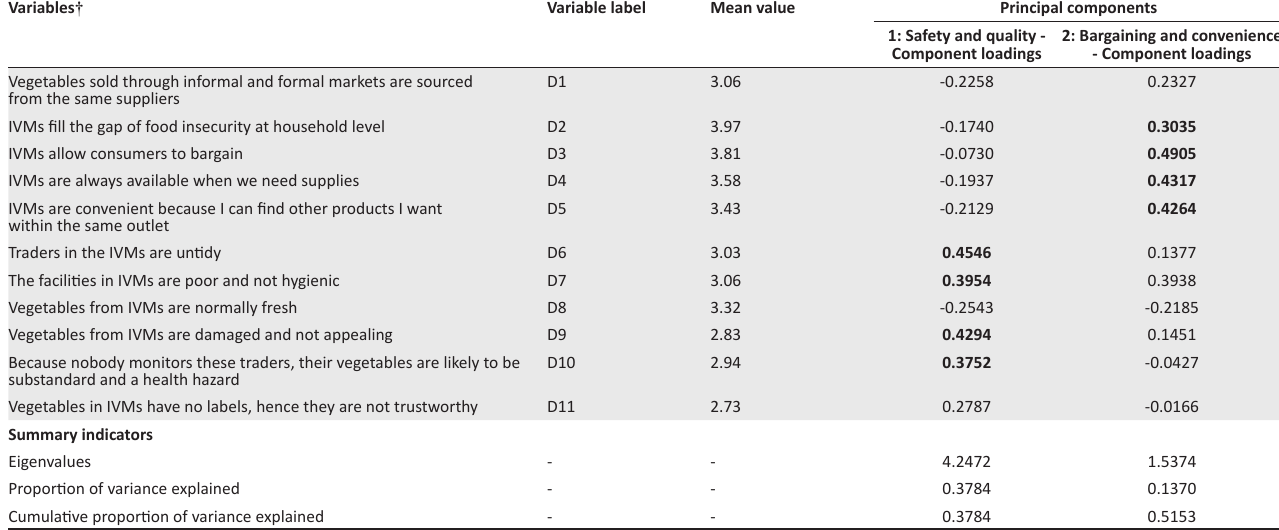
TABLE 2: Principal component analysis of urban households’ perceptions on informal vegetable markets, 2015 ( n = 230).